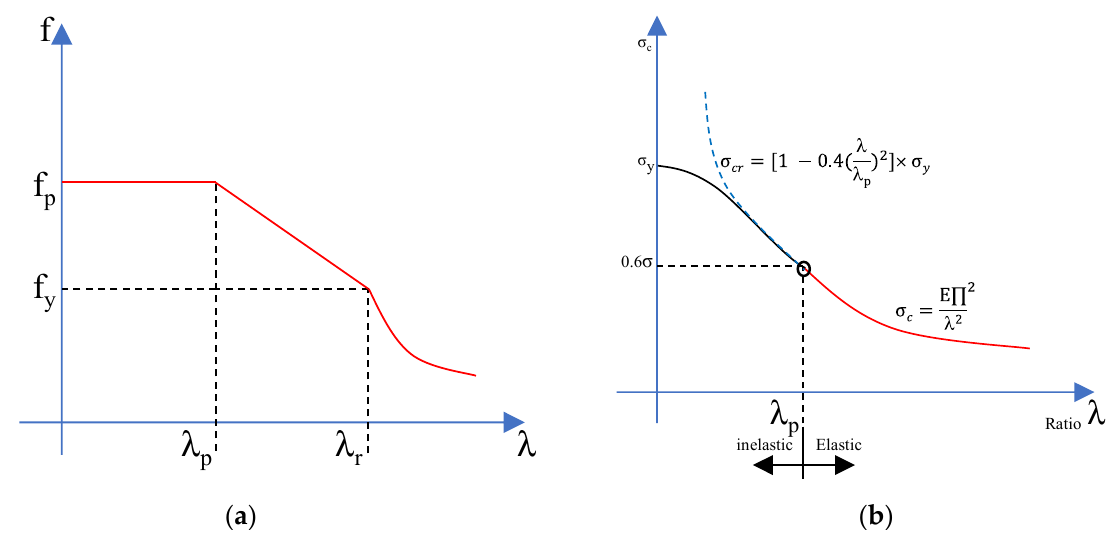
Figure 12. ( a ) Eurocode (CEN, 2011) and ( b ) Japanese code (Miki, 2000). Class limits.